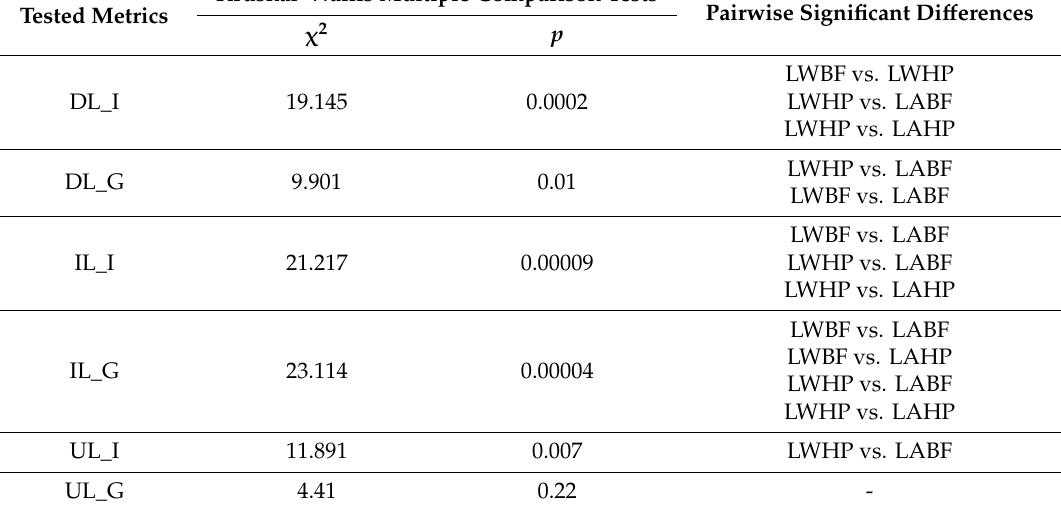
Table 3. Kruskal–Wallis results for the behavioral responses from L. bocagei (n = 45) in each L-structure (LW and LA) and event (BF and HP) and the correspondent pairwise significant differences (Dunn’s z-value > 1.96).